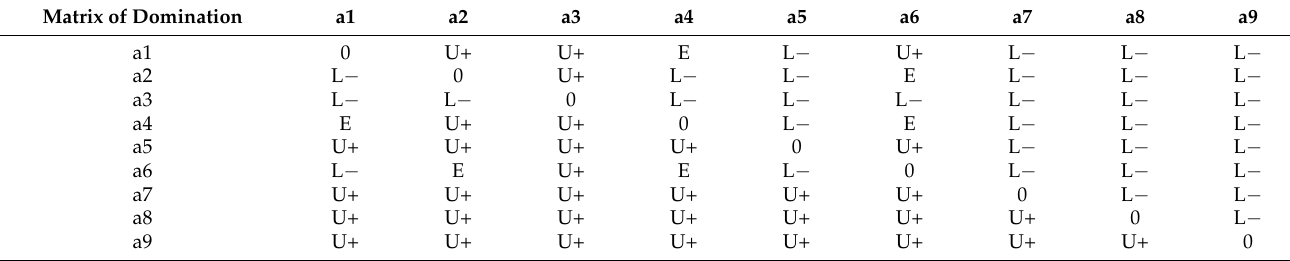
Table 6. Matrix of domination of the tested